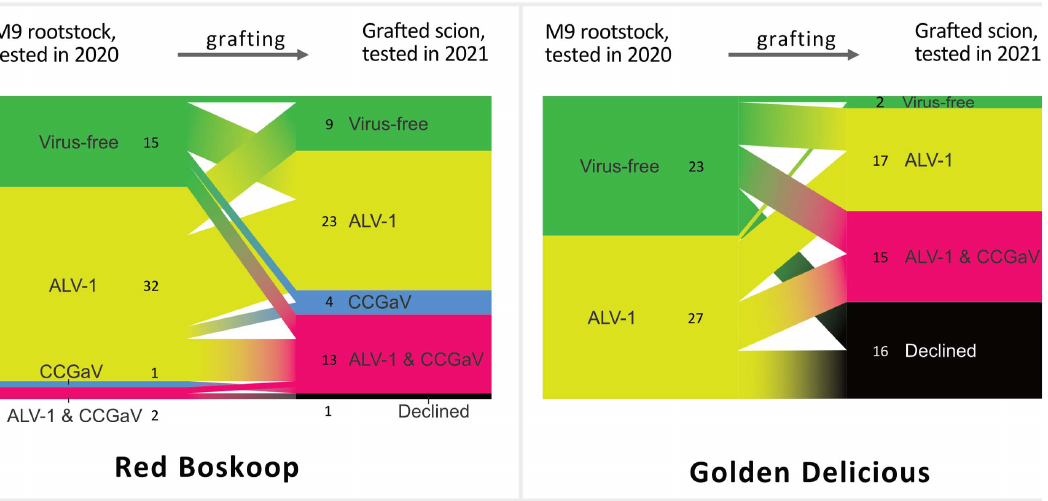
Figure 10. Details on graft transmission of ALV-1 and CCGaV from the M9 rootstock to RB and GD apple. The ALV-1/CCGaV status of the declined samples was not